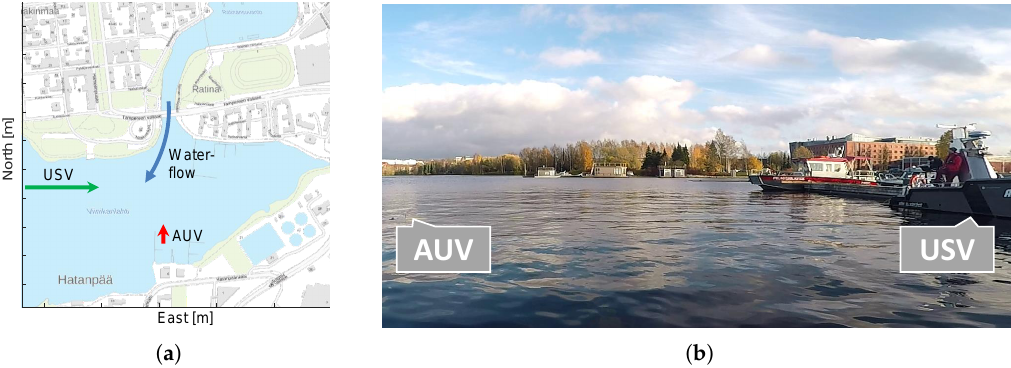
Figure 14. Control scenario: ( a ) Location of the AUV (red arrow) and USV (green arrow) field tests at the Pyhäjärvi lake in Tampere, Finland, being affected by the water-flow (blue arrow) from a hydro-power plant. ( b ) AUV and USV platforms at the harbor during the AUV field tests.